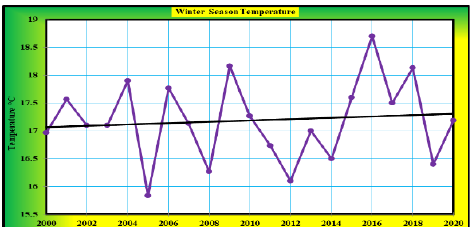
Figure 11: Represents Winter Season Temperature Trend Line in Ghotki